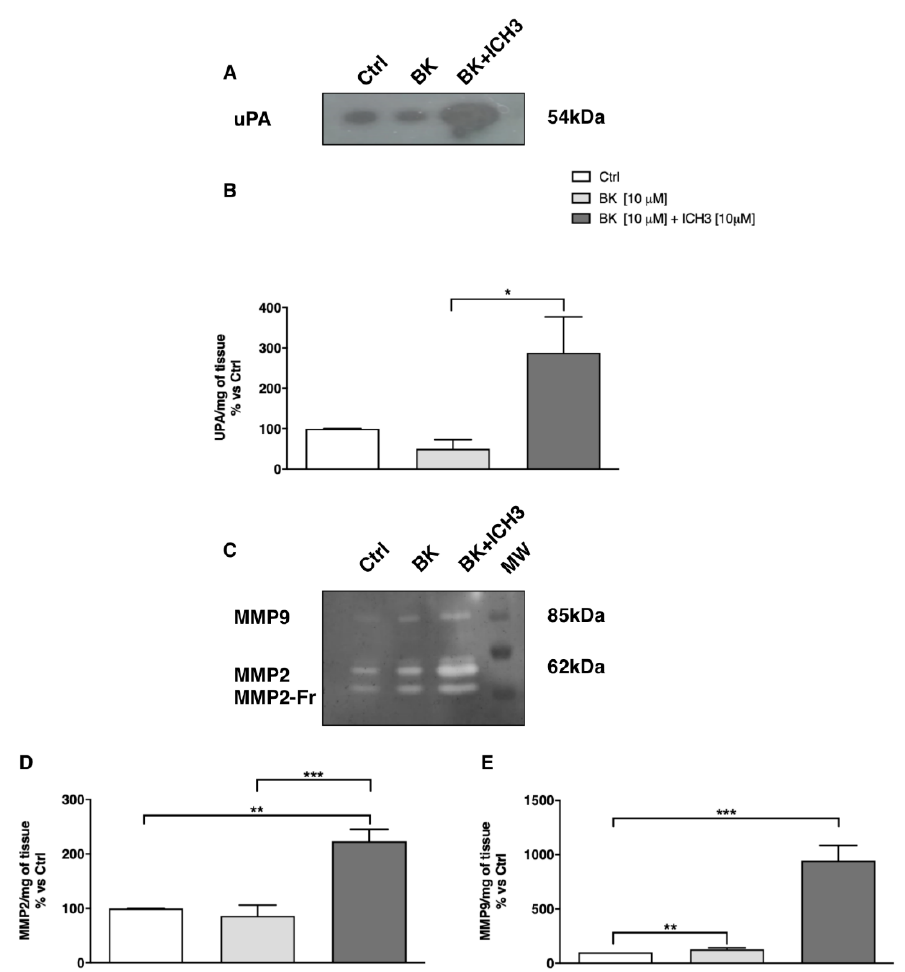
Figure 5. uPA and MMP2/MMP9 activity measured in the media of cultured sciatic nerves by zymography. ( A , B ) uPA activity is significantly increased after ICH-3 treatment (n = 3; * p < 0.05). ( C , D ) MMP2 and ( C – E ) MMP9 activities are significantly increased after 24 h of ICH-3 treatment (n = 3; ** p < 0.01; *** p < 0.001). PA and MMPs activities were expressed as percentage of control arbitrarily set at 100, and values were normalized to the value in milligrams of nerve tissue present in the culture dish.